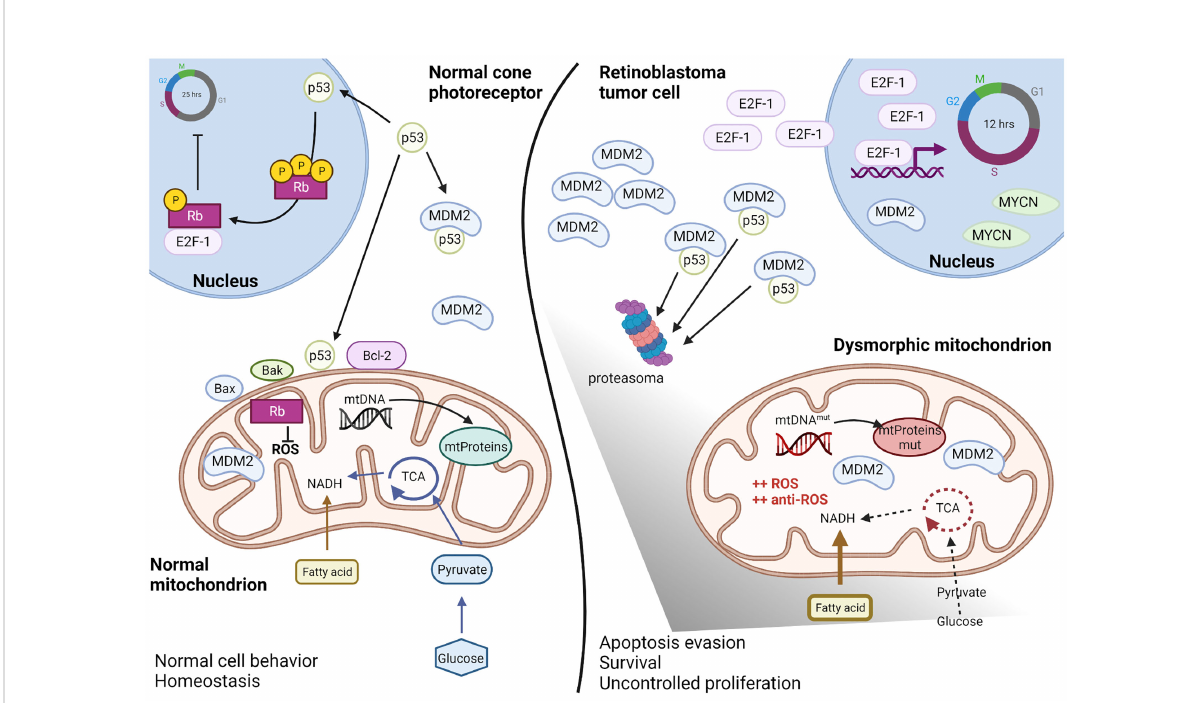
FIGURE 2 Altered mitochondria in retinoblastoma. Schematic representation of the altered mitochondria and cellular environment in retinoblastoma tumoral cell respect to a normal cone photoreceptor, as proposed by recent literature data discussed in paragraph 4. In the normal cell (left), basal levels of p53 can regulated both nuclear and mitochondrial effects and maintain the intracellular homeostasis. The presence of Rb protein guarantees both the cell cycle inhibition as well as the ROS control. In the retinoblastoma tumoral cell (right), Rb is lost and high levels of MDM2, E2F-1 and MYCN favorite p53 degradation and uncontrolled cell cycling. Mitochondria metabolism is deregulated with predominance of fatty acids instead of glucose consume, DNA mutations in the D-loop region and ROS hyper-production compensated by anti-ROS hyper-induction. Therefore, mitochondria appear dysmorphic and aberrant but functional for survival and apoptosis escape. Created with